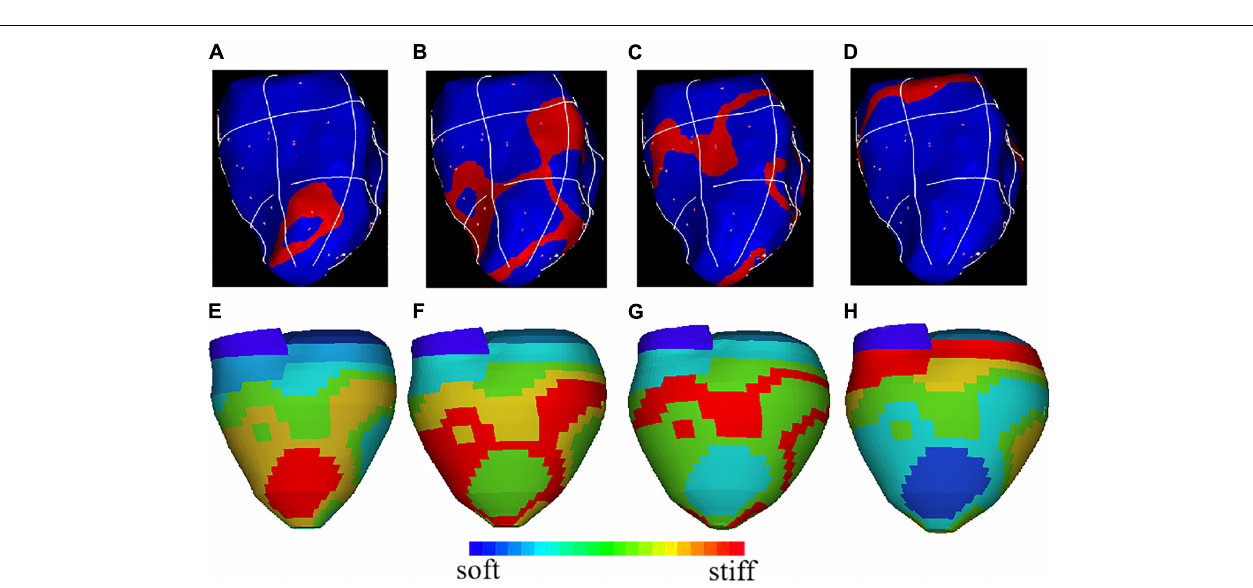
FIGURE 4 | The electrical signal conduction diagrams with right ventricular apex (RVA) pacemaker at different phases and the corresponding 3D geometry model showing regional stiffness variation. (A) Electric signal mapping during Phase 1; (B) . Electric signal mapping during Phase 2; (C) . Electric signal mapping during Phase 3; (D) . Electric signal mapping during Phase 4; (E) . Model stiffness mapping corresponding to (A) ; (F) . Model stiffness mapping corresponding to (B) ; (G) . Model stiffness mapping corresponding to (C) ; (H) . Model stiffness mapping corresponding to (D) .